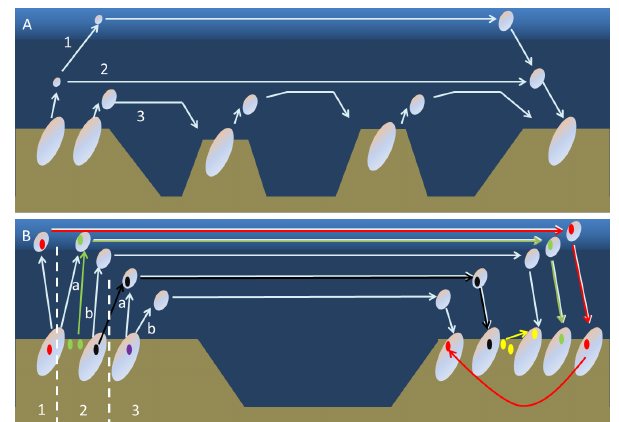
Fig. 4. (A) Dispersal strategies in bivalves. Long-distance, with planktotrophic larvae dispersing in the euphotic zone (1) or in a deeper water layer (2). Larvae can grow during dispersal and can settle very far from their birth site. Shorter-distance dispersal (3) can be achieved by lecithotrophic larvae, which live on maternal reserves and theoretically settle closer to their birth site. (B) Bacterial symbionts can be maternally inherited (1), acquired from free-living populations of bacteria at site of origin (2a, green bacterium) or at site of settlement (2b, yellow bacterium), or laterally acquired from another host at site of origin (3a, black bacterium) or at site of settlement (3b, red bacterium). Situations 1, 2a and 3a lead to host–symbiont co-dispersion, as emphasized by the bi-color arrows. Different transmission modes can co-exist within a given